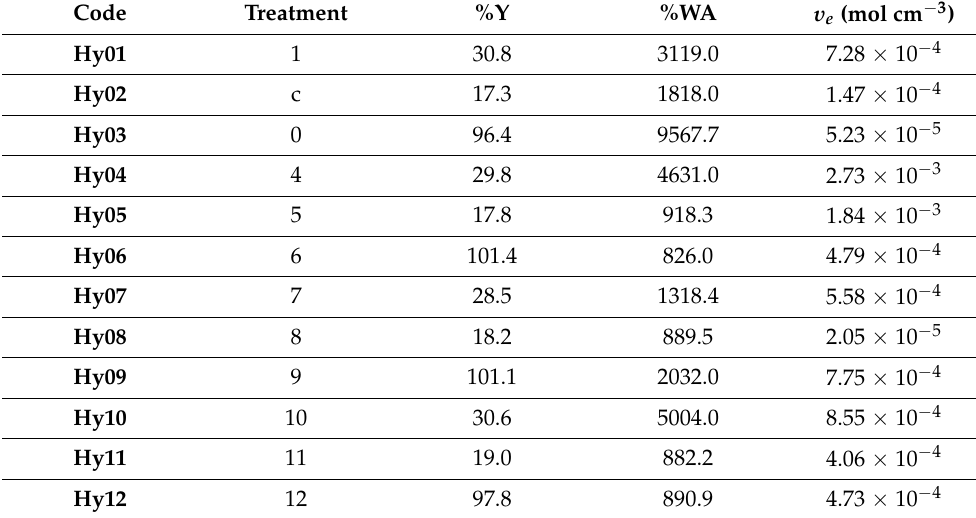
Table 3. Characterization results of the synthesized hydrogels: the reaction yields, water absorption, and effective cross-link density of the cross-linked structure of the 12 synthesized hydrogels. Code Treatment %Y